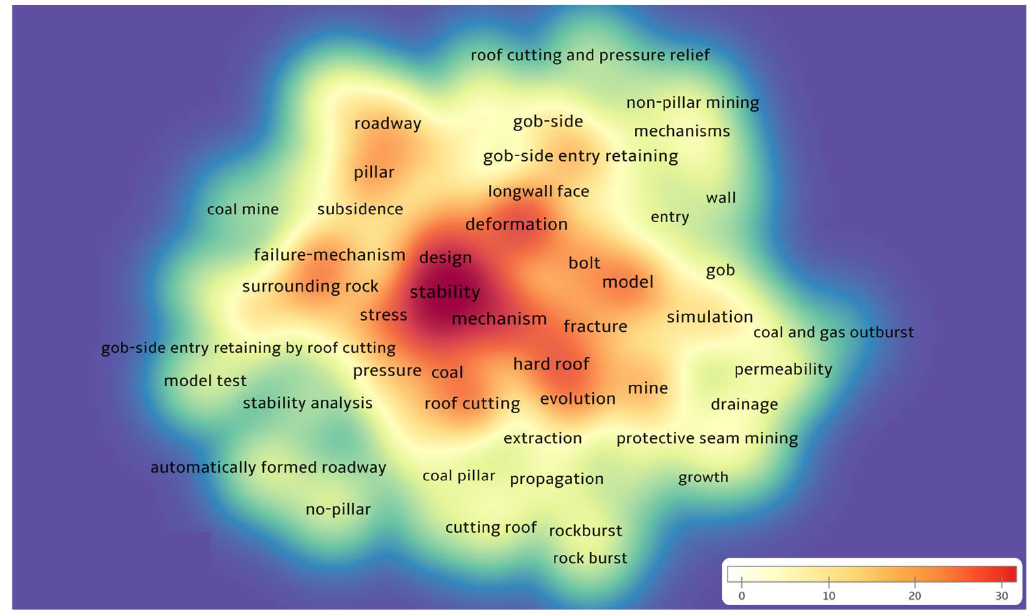
Figure 2. Research hotspot map of pre-splitting and roof-cutting technology.